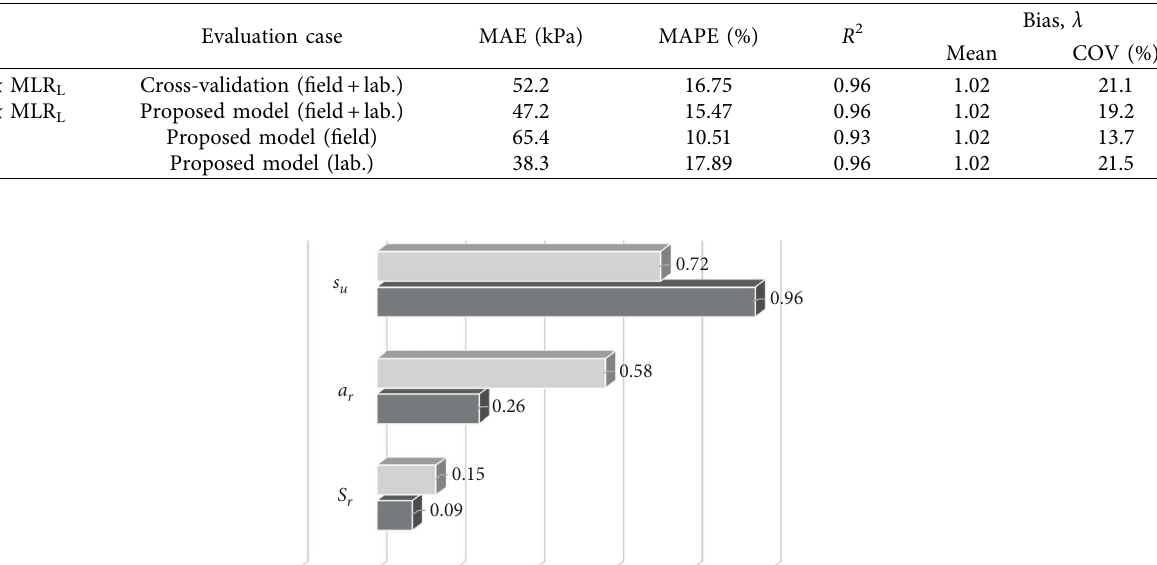
Figure 7: Comparison of observed and predicted ultimate bearing capacity by the proposed MLR models for approach 2. Table 7: Prediction performance of the proposed model and it cross-validation (approach 2).